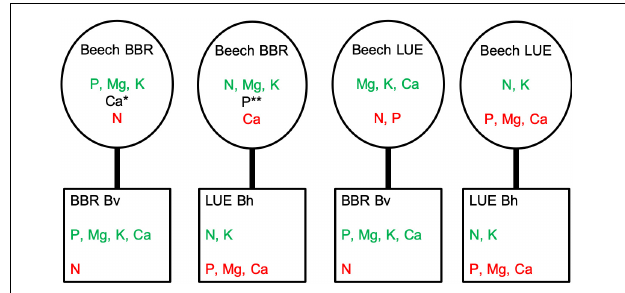
FIGURE 5 | Evaluation of plant nutritional status and effective nutrient availability in the soil in a rhizobox experiment with beech ( Fagus sylvatica L.) saplings originating from the sites Bad Brückenau (BBR) and Unterlüss (LUE). The saplings were grown in material from the Bv horizon at BBR or from the Bh horizon at LUE. For the plant nutritional status (i) the comparison of foliar nutrient concentrations and ratios ( Table 2 ) with published threshold values (Mellert and Göttlein, 2012; Göttlein, 2015; green normal or surplus; red deficient or above/below normal) and (ii) the average nutrient concentrations in the whole plant (green low, red high) are considered; the assessments agree except for *: foliar Ca in deficient range, N/Ca in normal range; **: foliar P in deficient range, N/P above normal range, whole plant P high; effective nutrient availability in the soil (green sufficient, red not sufficient) is estimated from the influence of the factor “current soil” on the plant nutritional status in the second year of the